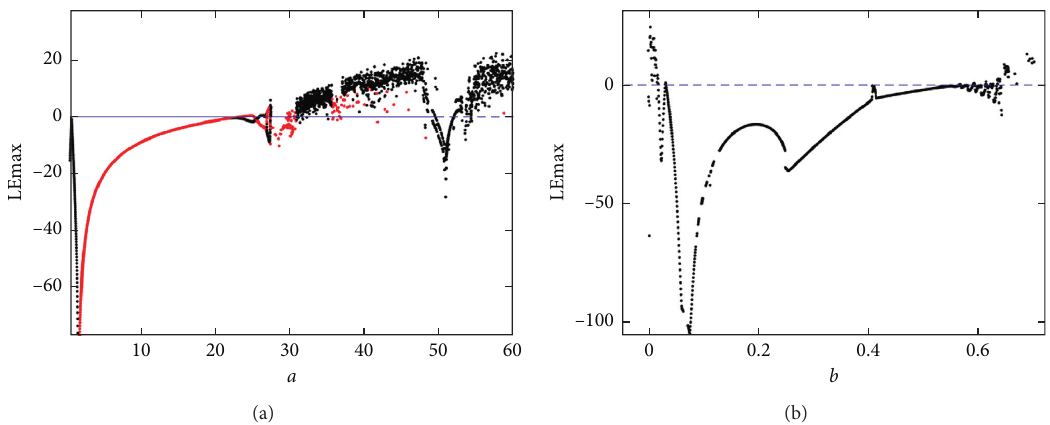
Figure 6: (a) Lyapunov exponent of equation (3) with c � 0 . 8 , β � 22, b � 0.7, and 0 < a < 60; (b) Lyapunov exponent of equation (3) with c � 0 . 8 , β � 22, a � 38, and 0 < b <